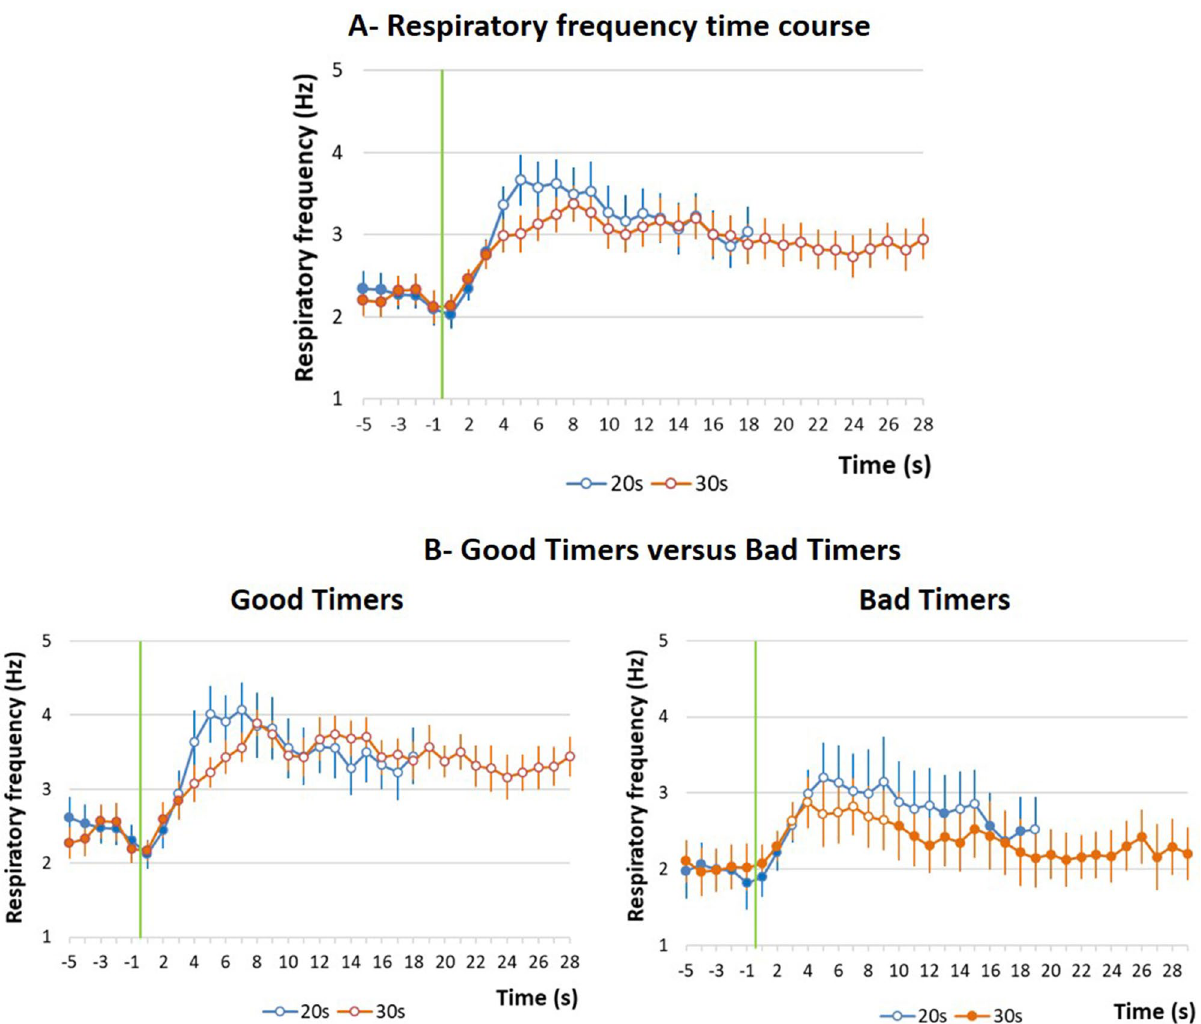
Figure 2. ( A ) Respiratory frequency time course in Group 20 s. The time course of respiratory frequency is represented with a 1-s bin precision, from 5 s before odor onset (green vertical line) to shock arrival which occurred either at 20 s (Conditioning session, in blue) or at 30 s (Shift session 2, in orange). ( B ) Good Timers versus Bad Timers subgroups. In Good Timers subgroup, the temporal patterns of respiratory frequency were modulated by the duration of the odor-shock interval, whereas in Bad Timers subgroup, they were not. Open circles on each curve signal the values that are significantly different from the baseline (p ≤ As depicted on Fig. 2A, shifting from a 20 s interval to a 30 s interval resulted in an increase of the mean latency to the peak respiratory frequency on the temporal curve (5 s for 20 s interval vs 8 s for 30 s interval).